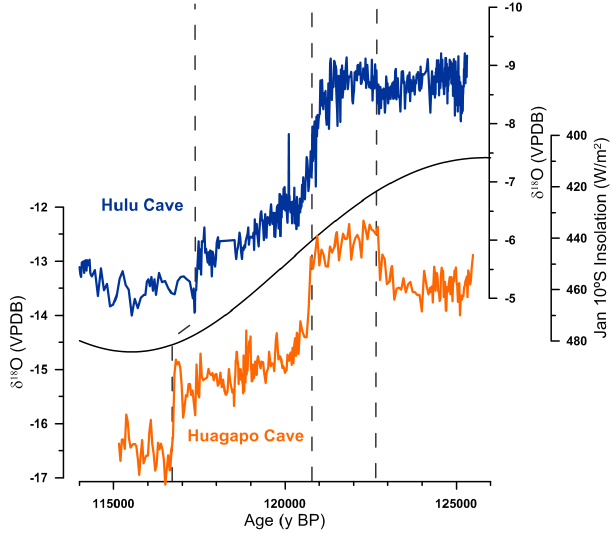
Figure 1. Age versus depth for stalagmite P10-H1. Error bars are 2 σ .